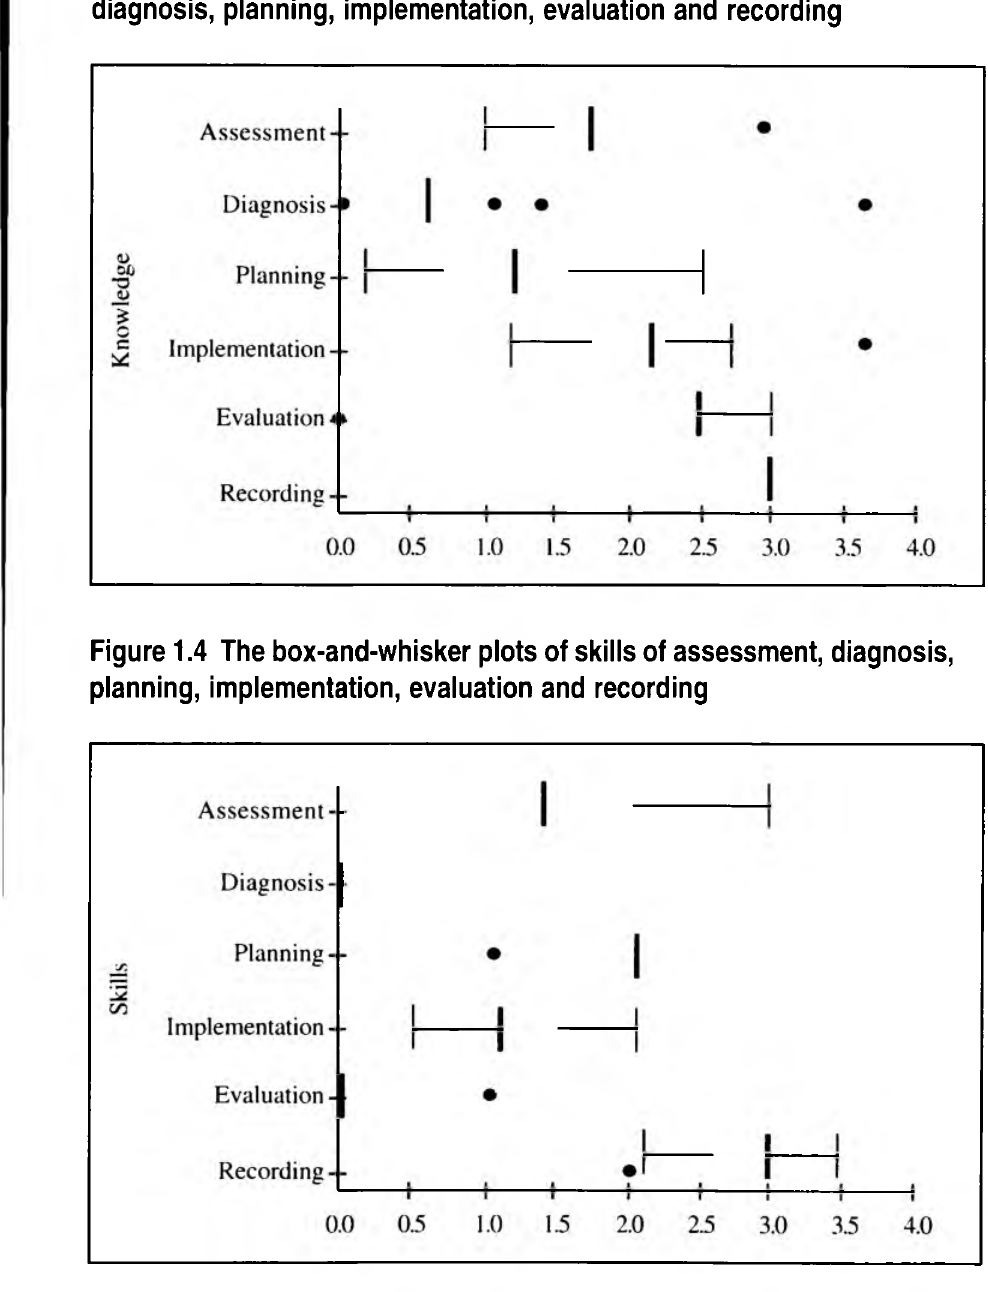
Figure 1.5 The box-and-whisker plots on knowledge of attitudes and values of